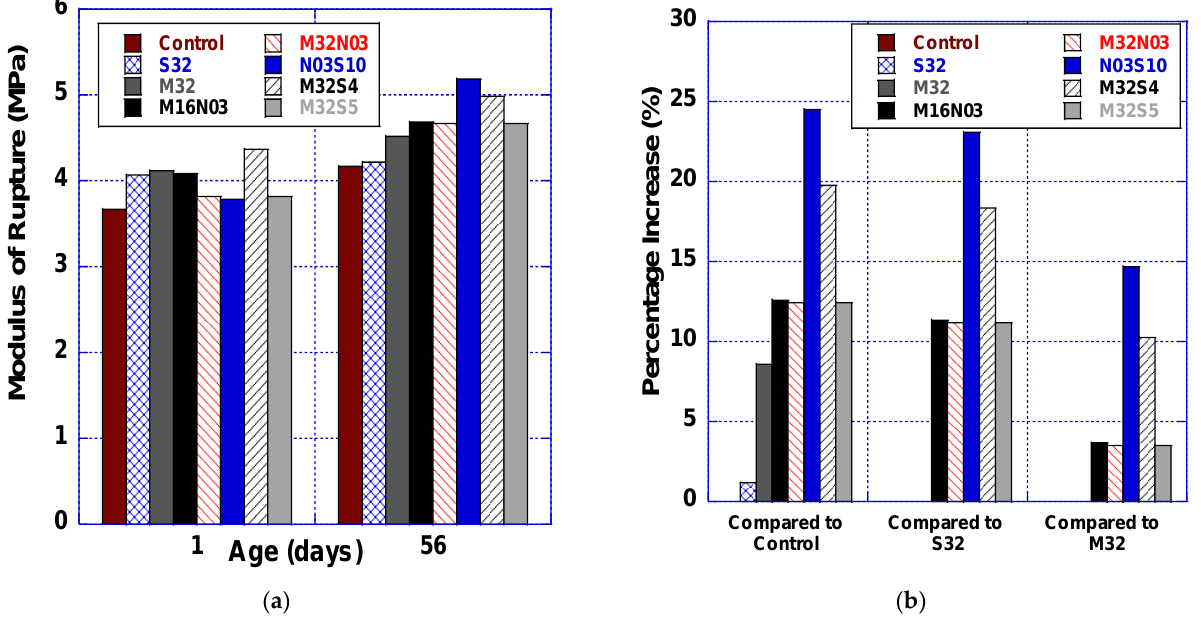
Figure 3. Modulus of rupture ( a ) testing results and ( b ) percentage increase compared to control mixes (Control, S32, M32).